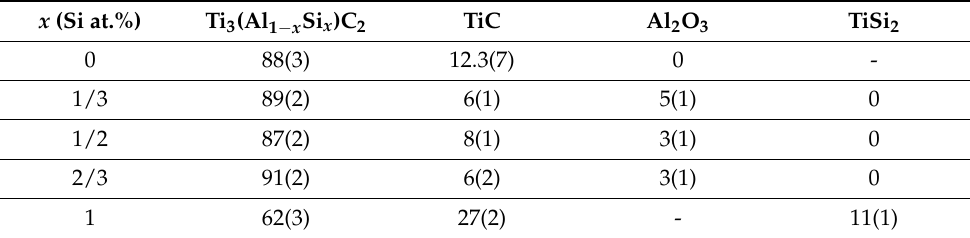
(space group R 3c) are secondary